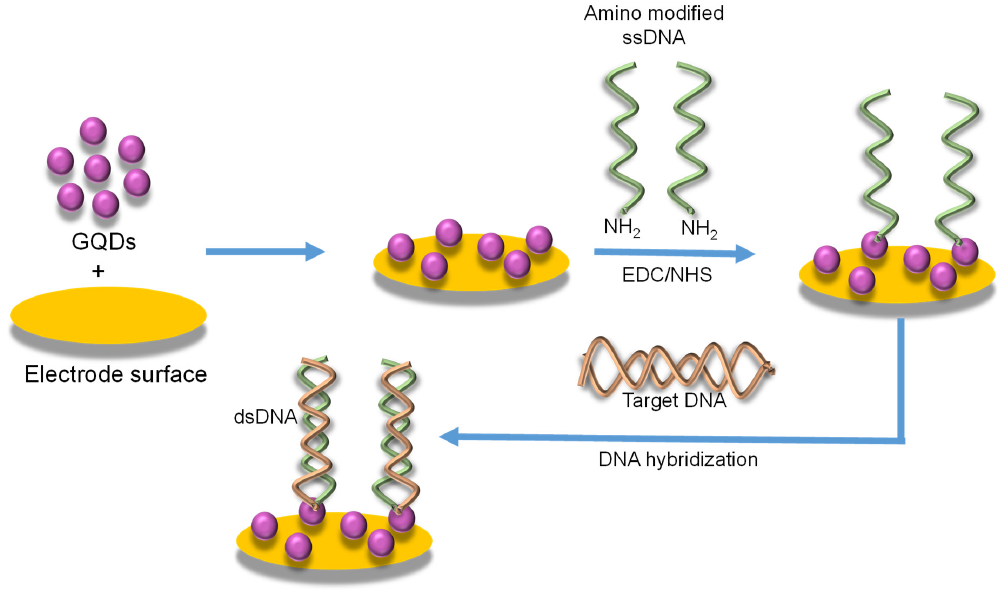
Figure 16. An example of a GQD-based electrochemical DNA biosensor.